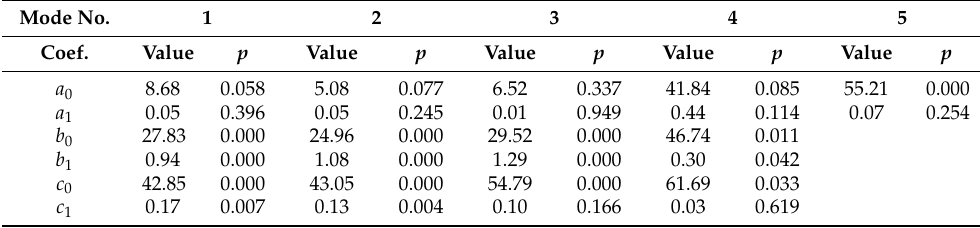
Table 4. Piecewise linear approximation coefficients of Fe content (%) in the bimetal interface zone. Mode